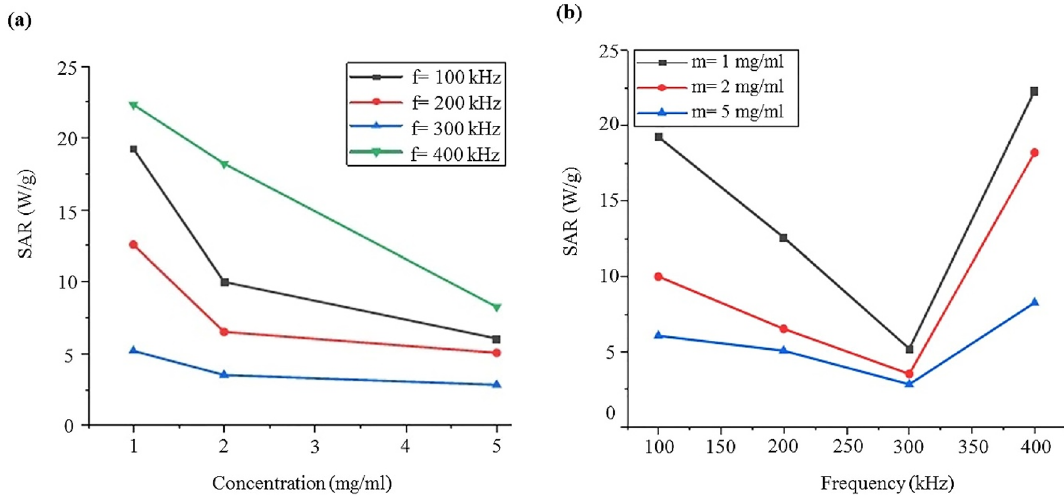
Figure 6. ( a ) Concentration dependence of SAR at the frequencies of 100, 200, 300, and 400 kHz, ( b ) frequency dependence of SAR at the concentrations of 1, 2, and 5 mg mL −1